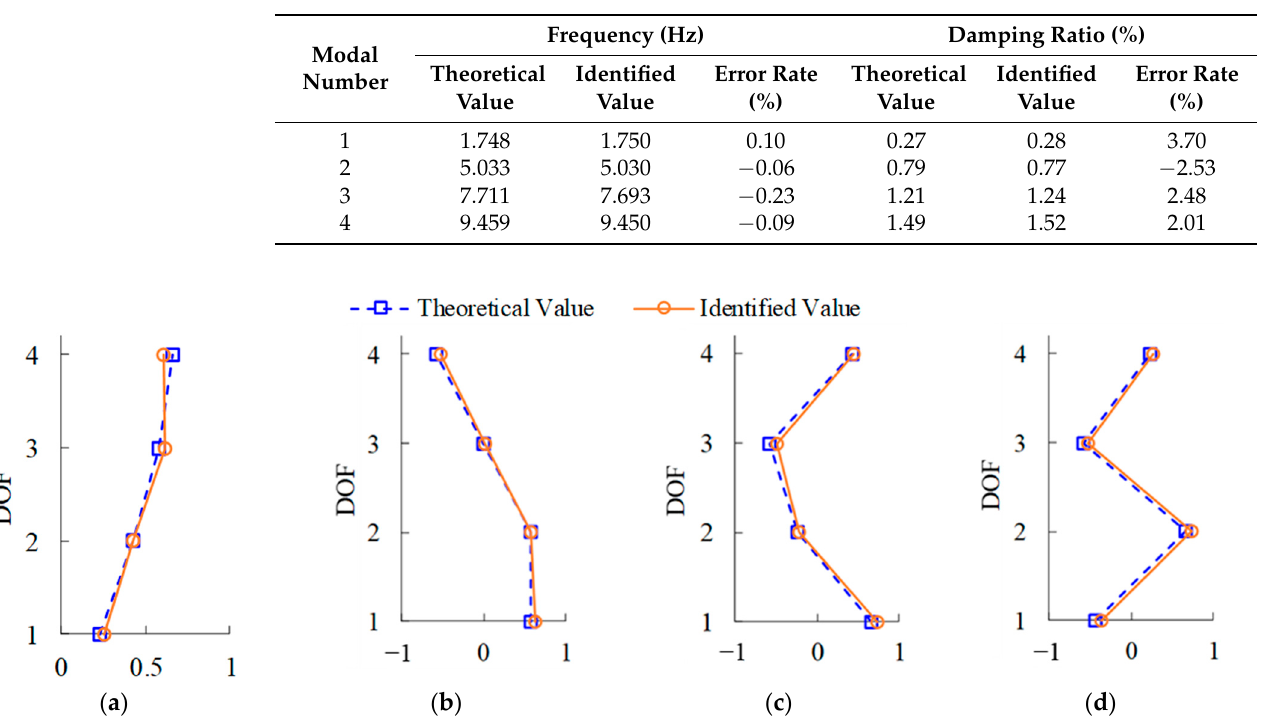
Table 2. Identification results of the modal frequency and damping ratio of the 4-DOF system.